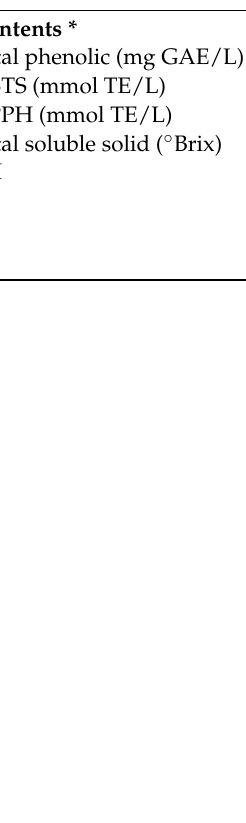
Table 1. Total phenolics compounds, antioxidant capacity, and general characteristics of tea infusion samples. Moringa Tea